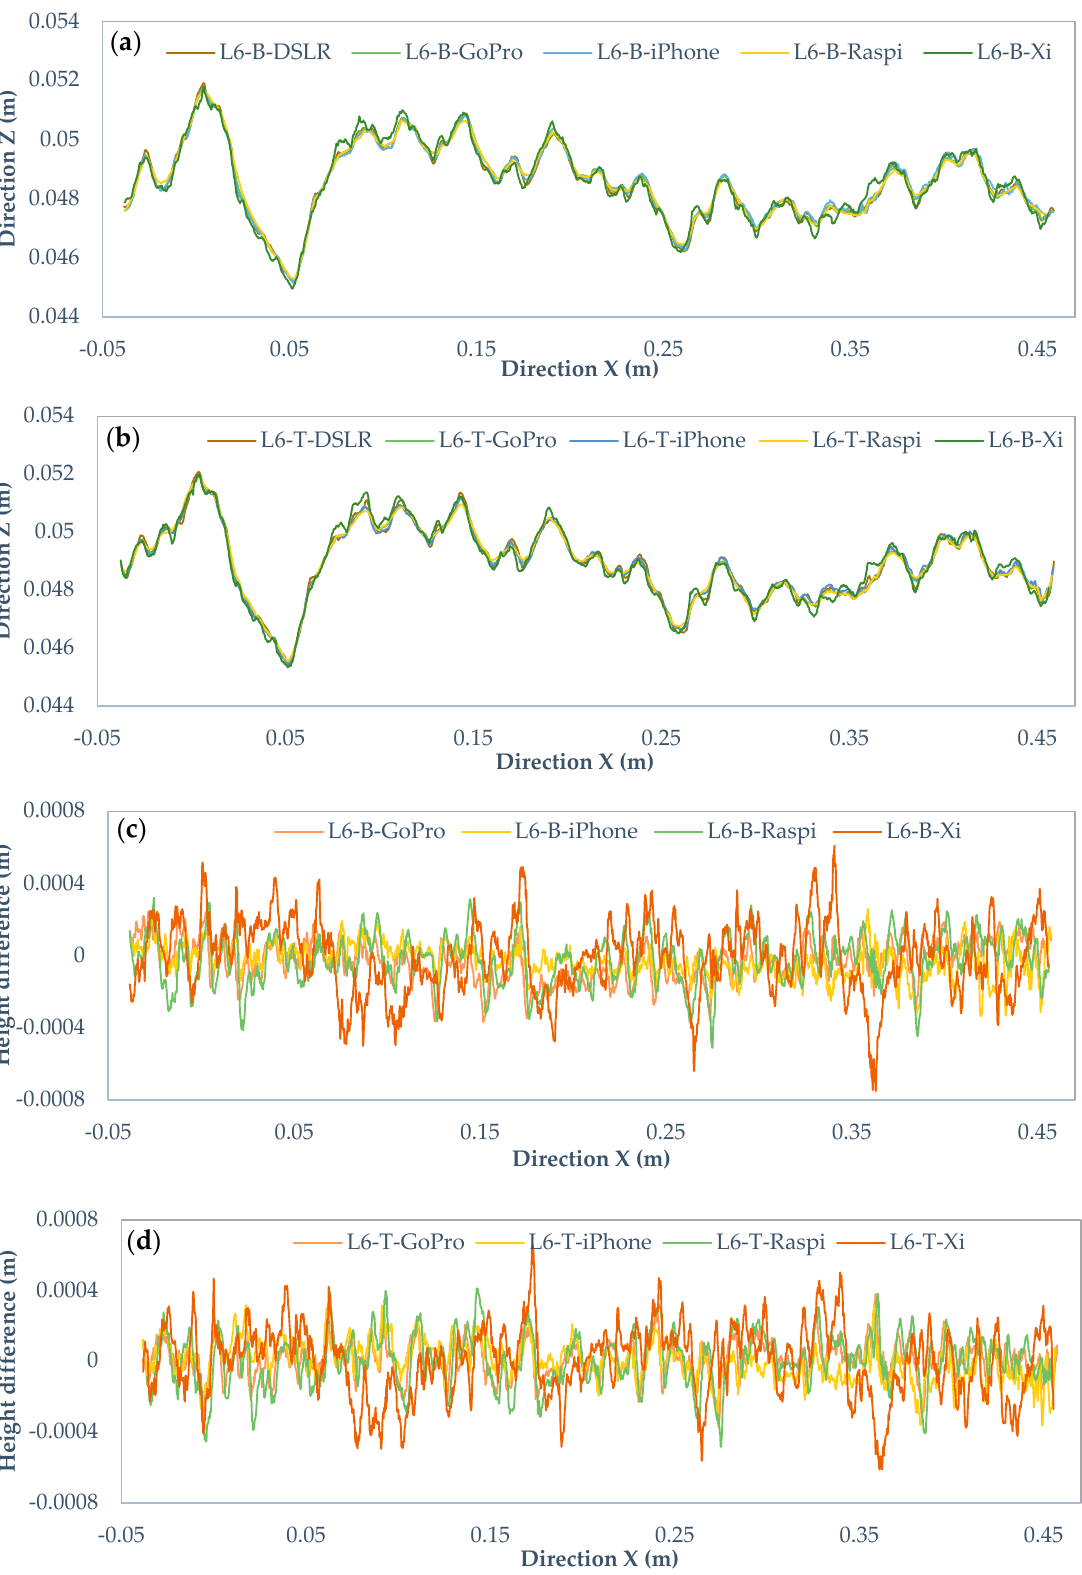
Figure 14. Comparison of the Canon EOS 5DS R DSLR and low ‐ cost camera profiles with 0.25 mm rasterization grid interval. ( a ) Original profiles of bottom surface, ( b ) top surface, ( c ) height differences of bottom profiles, and ( d ) top profiles.